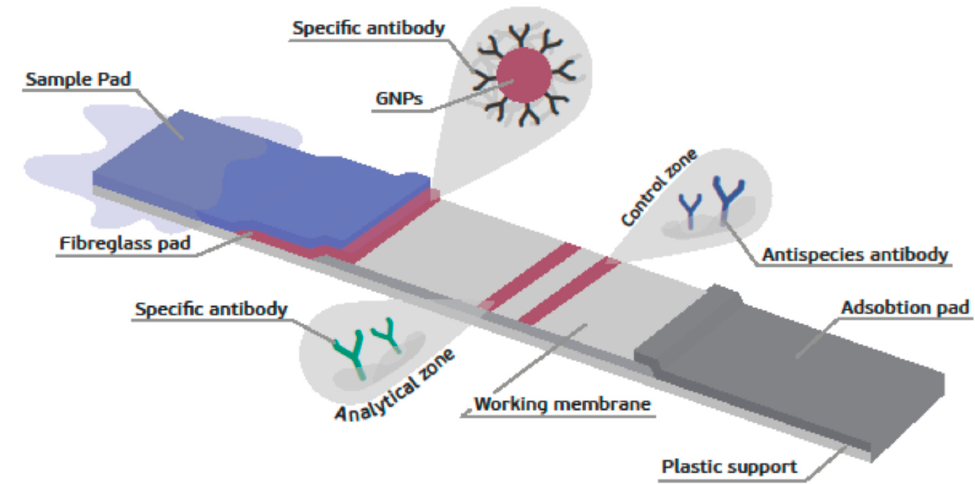
Figure 3. Scheme of the sandwich format LFIA.